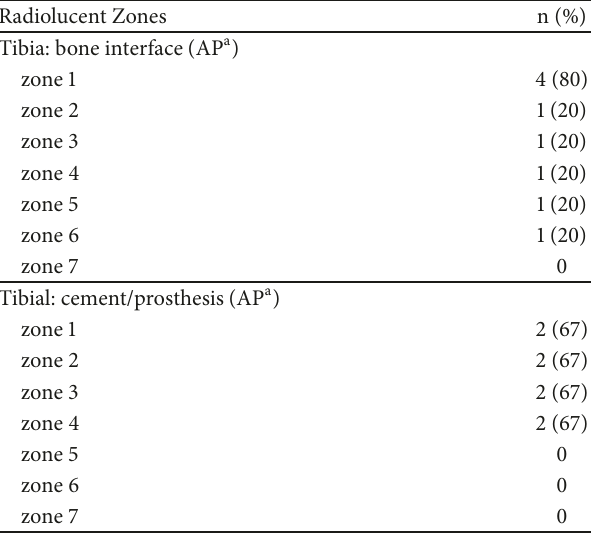
Table 6: Frequency of radiolucent lines in the anteroposterior (AP) tibial zones.